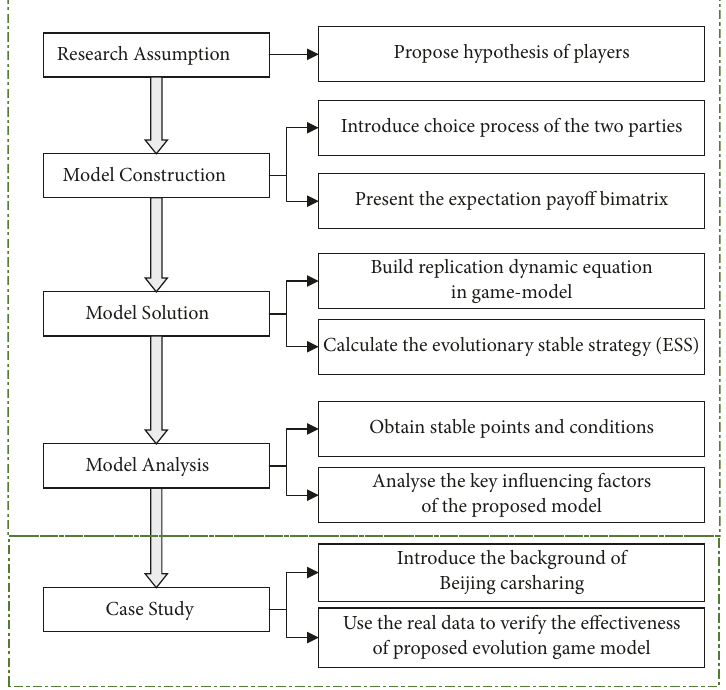
Figure 2: Framework of the